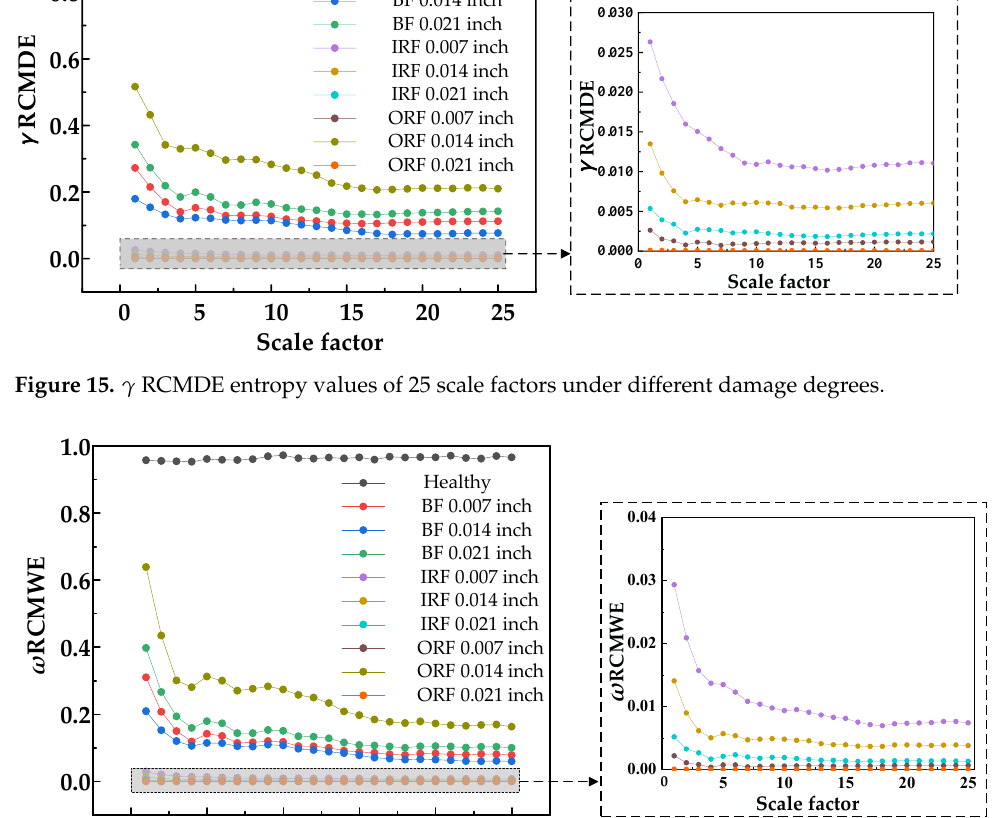
Figure 16. ω RCMWE entropy values of 25 scale factors under different damage degrees.